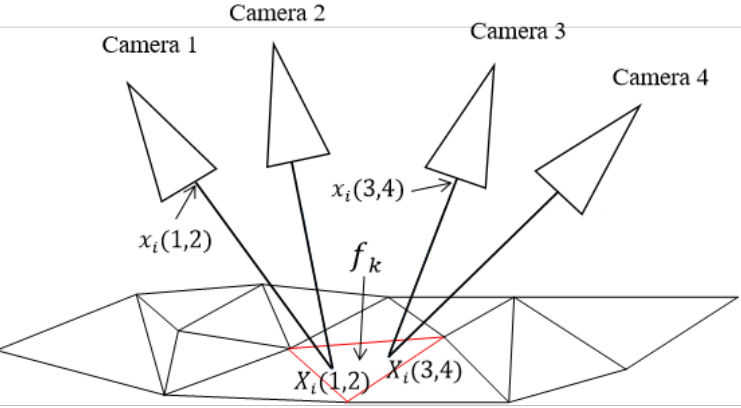
Figure 5. The schematic diagram for the calculation of the ZNCC value of face f k . The red triangle represents f k . All the image pairs visible to f k are considered for the ZNCC calculation, indicated as images from Camera 1 to 4 in this figure.